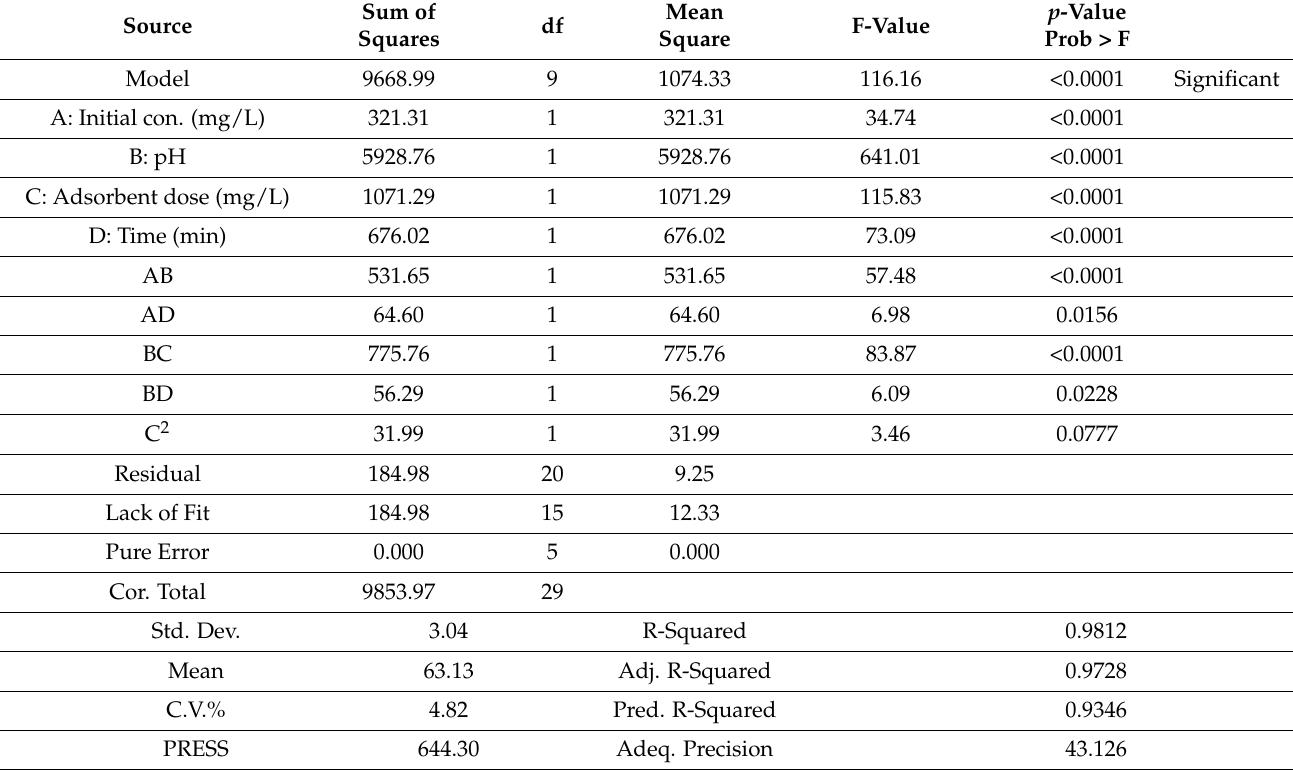
Table 4. ANOVA results for the MB dye removal